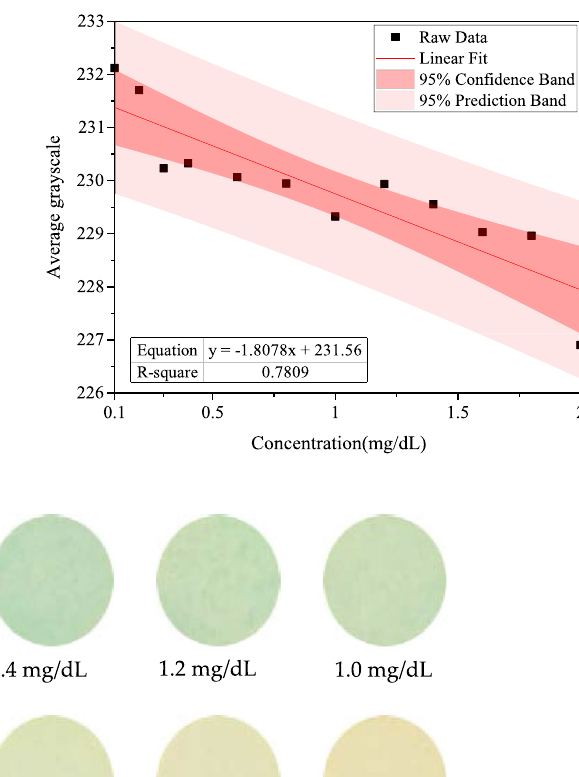
Fig. 7 Linear relationship between different concentra- tion of direct bilirubin test paper and average grayscale of G channel using a D2 lamp